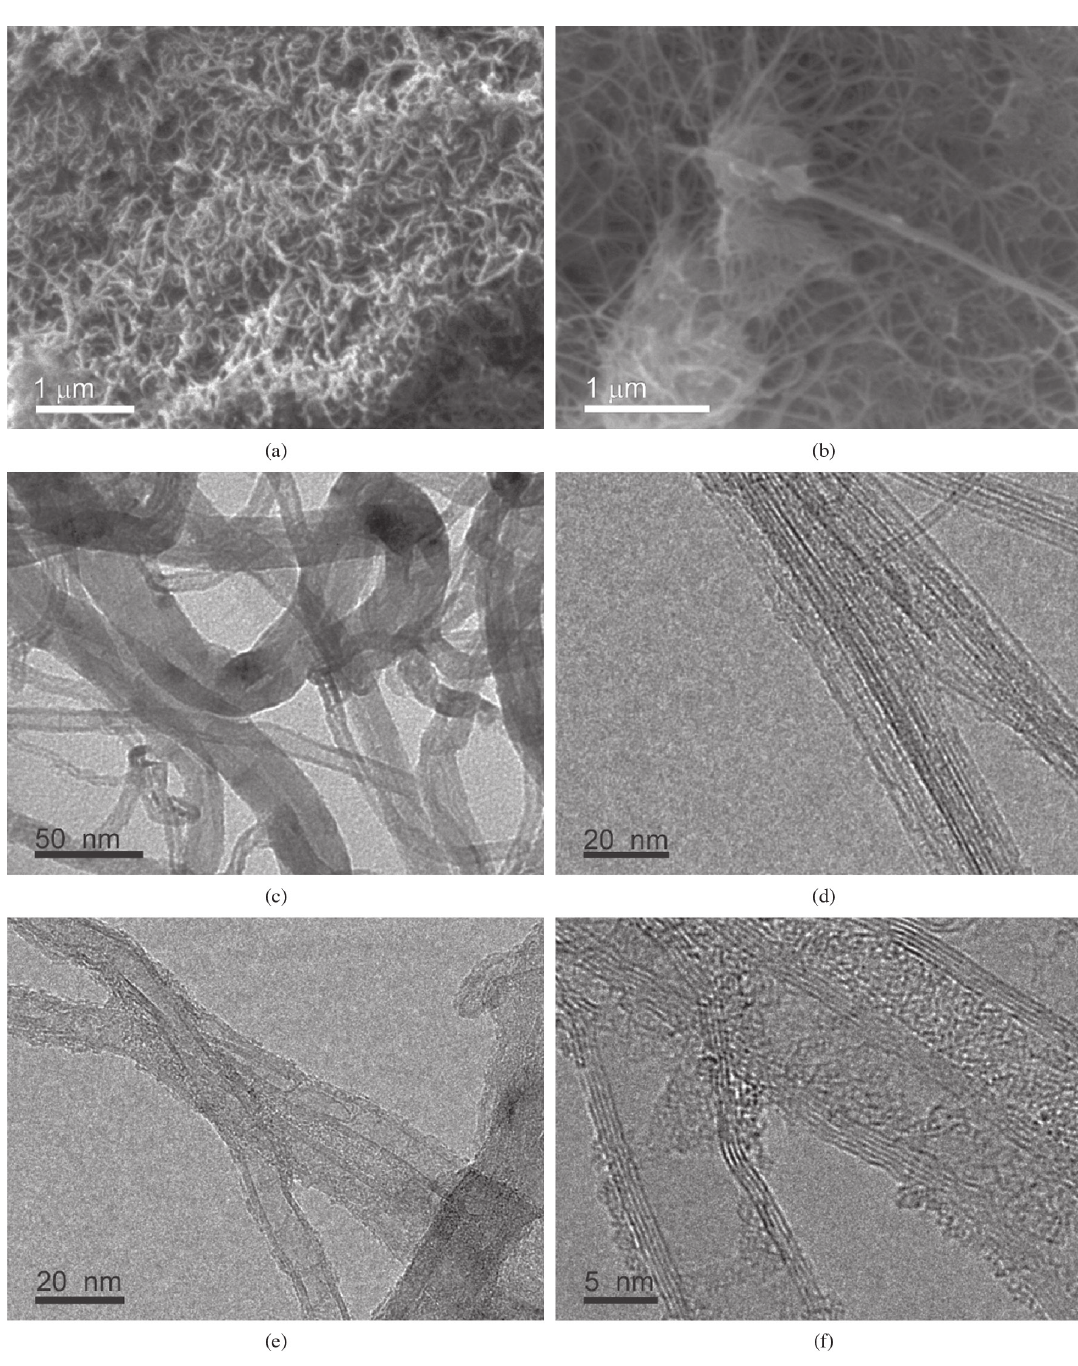
In this present work, the Langmuir, Freundlich and Liu isotherm models were tested 19 . The Langmuir isotherm model is based on the following principles 19 : adsorbates are chemically adsorbed at a fixed number of well-defined sites; each site can only take one adsorbate species; all sites are energetically similar; there are no interactions between the adsorbate species. The Freundlich isotherm model assumes that the concentration of the adsorbate on the adsorbent